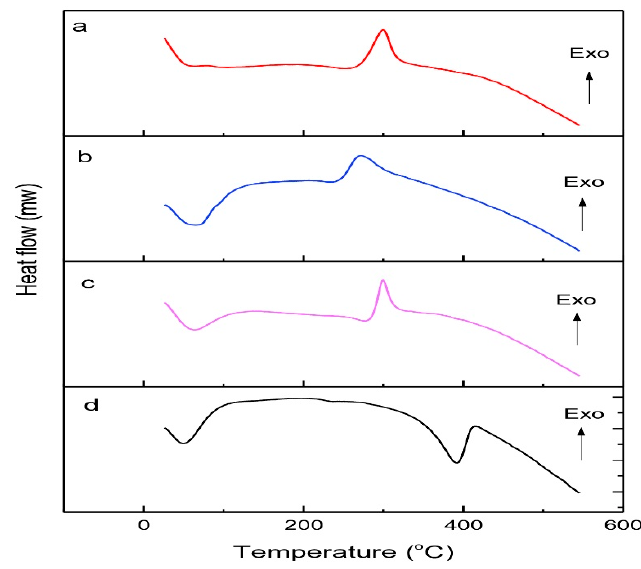
Figure 7. DSC thermogram of ( a ) low molecular weight chitosan, ( b ) native chitosan, ( c ) comer- cial chitosan, and ( d ) chitin.